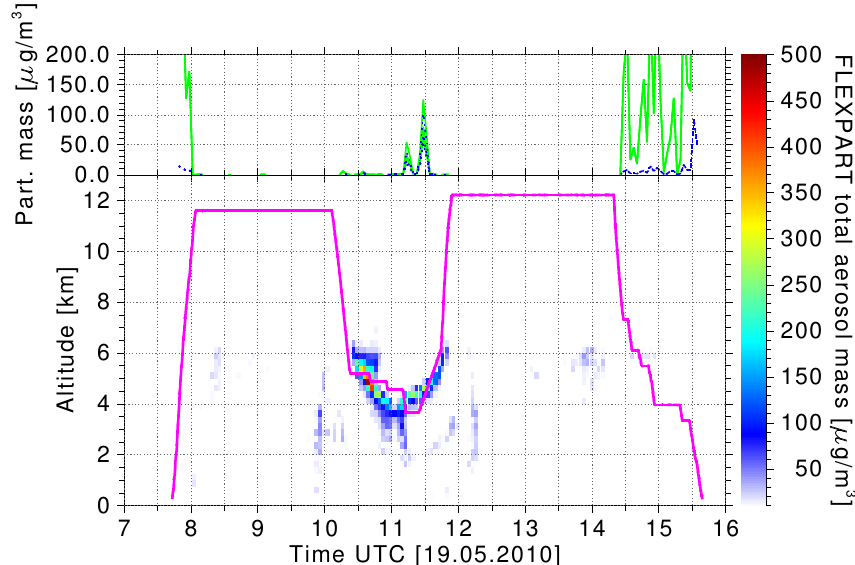
Fig. 11. Particle measurement and model comparison for flight on 19 May 2010. Upper panel: OPC total particle mass concentration for particles larger than 138nm calculated with the smallest slope (solid green lines) and largest slope (dotted blue lines) in the size distribution extrapolation. The three lines are calculated assuming different refractive indices for the volcanic ash particles (see text). Lower panel: simulated vertical distribution of the ash along the CARIBIC flight track from the FLEXPART model. Same representation as in Fig.